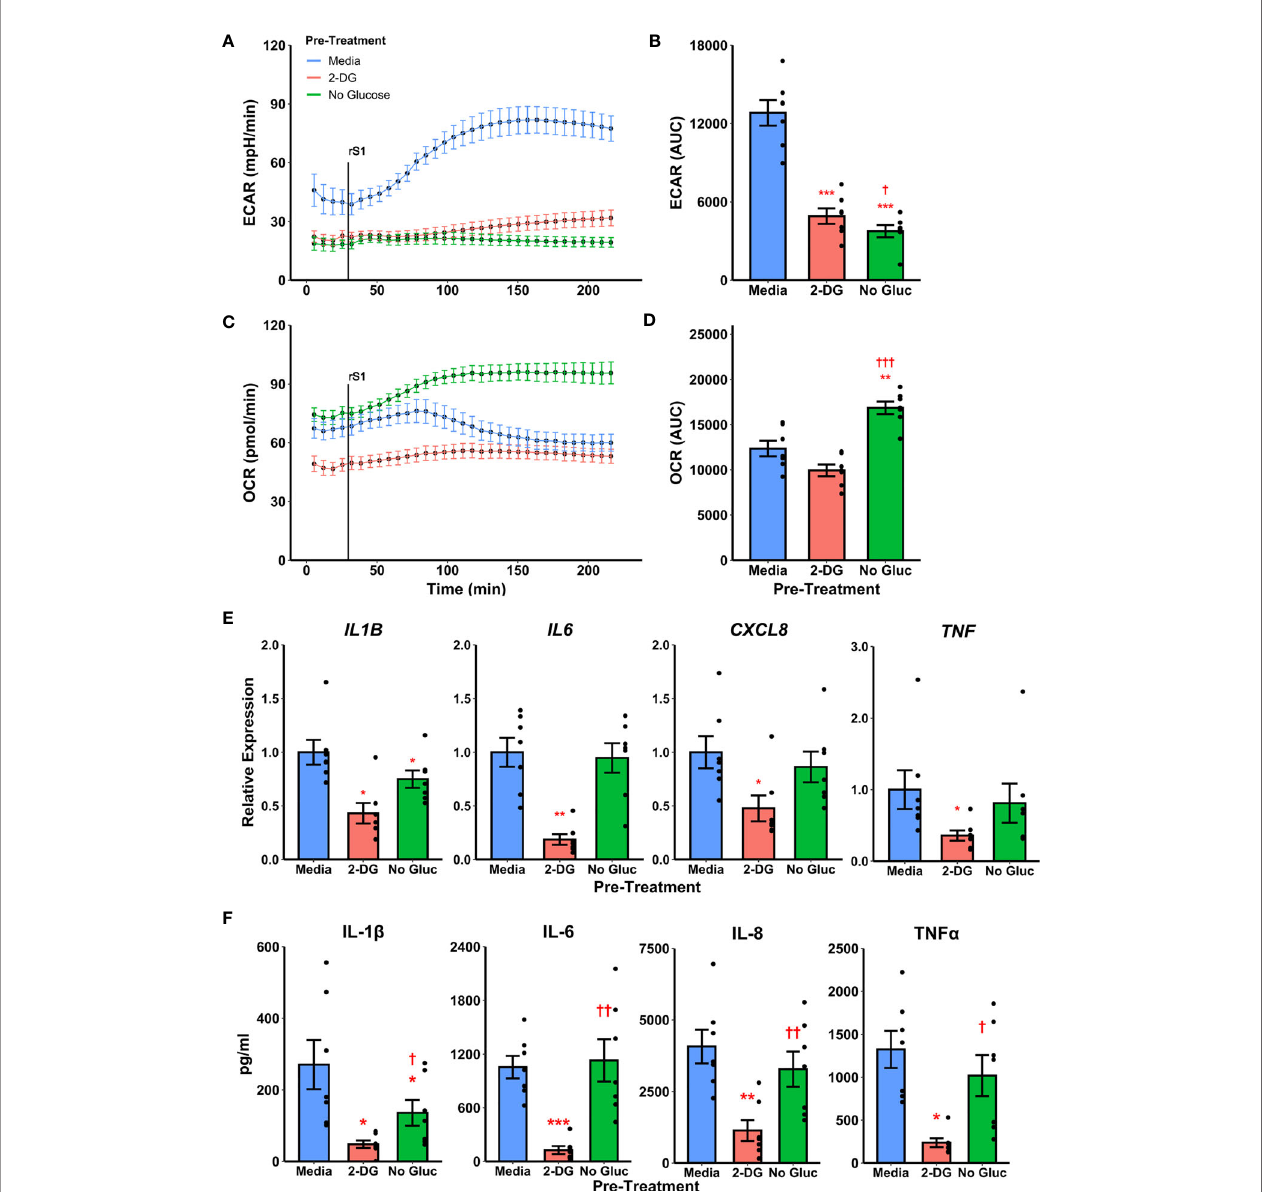
FIGURE 4 | Targeting glycolysis has variable effects on recombinant spike protein (rS1) responses in monocytes. (A) Glucose deprivation or pre-treatment with 2- deoxyglucose (2-DG) block extracellular acidi fi cation rate (ECAR) increase due to rS1 treatment. (B) Quanti fi cation of ECAR by area under the curve (AUC). (C) 2-DG inhibits oxygen consumption rate in rS1-treated monocytes, but glucose-deprived monocytes upregulate OCR in response to rS1. (D) Quanti fi cation of OCR by AUC. (E) 2-DG blocks expression of IL1B , IL6 , CXCL8 , and TNF due to rS1 stimulation, but glucose deprivation has limited effects on cytokine expression. (F) 2-DG blocks protein production of pro-in fl ammatory cytokines, but glucose deprivation has limited effect. *, **, ***: p < 0.05, p < 0.01, p < 0.001 vs . rS1-treated cells. † , †† , ††† : p < 0.05, p < 0.01, p < 0.001 vs . 2-DG-treated cells. N = 7 biological replicates. Bars and error bars are mean ±